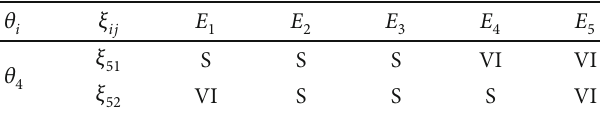
Table 3: Appropriateness ratings (in linguistic scale) against CRPAI subdimensions assigned by